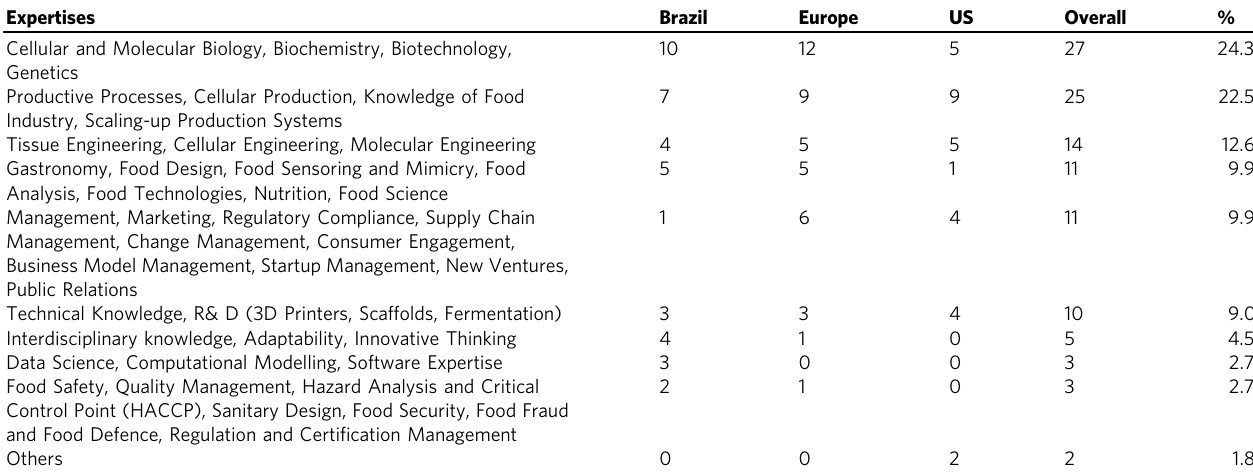
Table 8 Analysis regarding the most required expertise and background knowledge of human resources at the fi rst stage of the cultivated meat value chain in Brazil ( N = 26), Europe ( N = 28) and the United States ( N = 23), using an open-ended